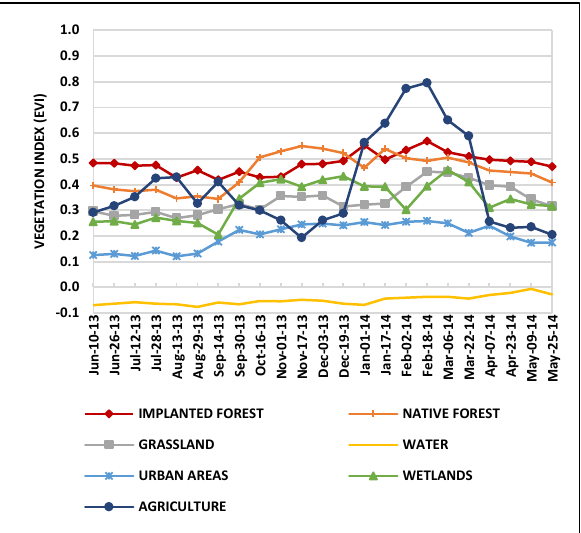
Figure 3. Characteristic phenological signatures of different land use and land covers in Uruguay.